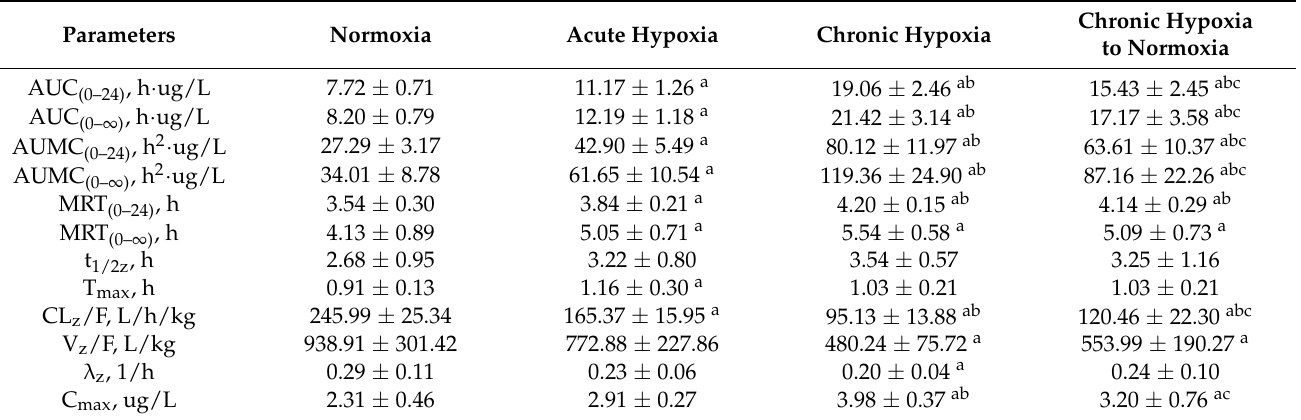
Table 6. Pharmacokinetic parameters of dehydronifedipine in rat plasma after exposure to high- altitude hypoxia.